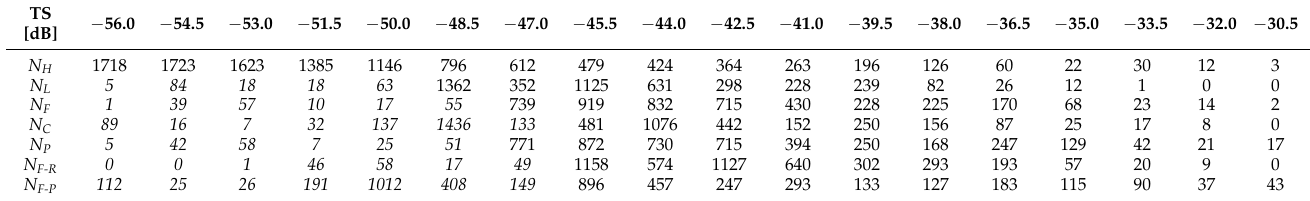
Table 2. Size structure of registered echoes (number of fish— N H ), by target strength ( TS in dB) on 7/8 October 2021, and the number of fish caught with gillnets on 27–30 September 2021, in TS classes (with a spread of 1.5 dB) based on various TS – TL relationships (Equations (1)–(6)). Subsets of data after removal of fish smaller than the TS for the small fish threshold (defined for each TS – TL relationship) are marked in plain font, and deleted data are in italics (explanations in the